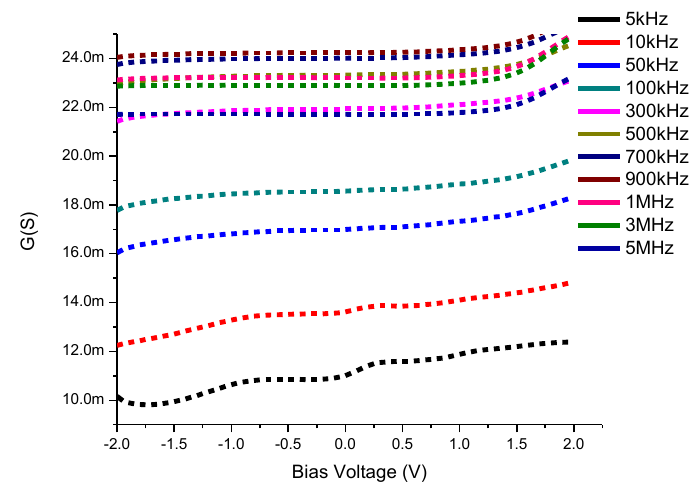
Figure 8. Conductance-Voltage (G-V) characteristics of CdS QD based on screen-printed TiO 2 .